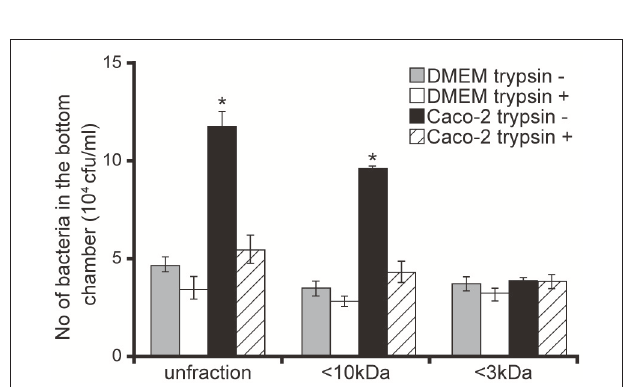
FIGURE 2 | Characterization of Caco-2 cell supernatant facilitating penetration of P. aeruginosa PAO1 strain through the mucin layer. A 15-day Caco-2 cell supernatant and Dulbecco’s modified Eagle medium (DMEM; control) were filtered through 10- or 3-kDa MW cut-off membranes and treated with or without a trypsin (trypsin + or − ). The filtered and unfiltered samples with or without trypsin filled the bottom chambers of Transwell. The P. aeruginosa PAO1 strain was added to the top chambers, and after 3 h, the numbers of bacteria in the bottom chambers were counted. Error bars indicate standard error ( n = 3). * P < 0.05 compared with DMEM of the same fraction